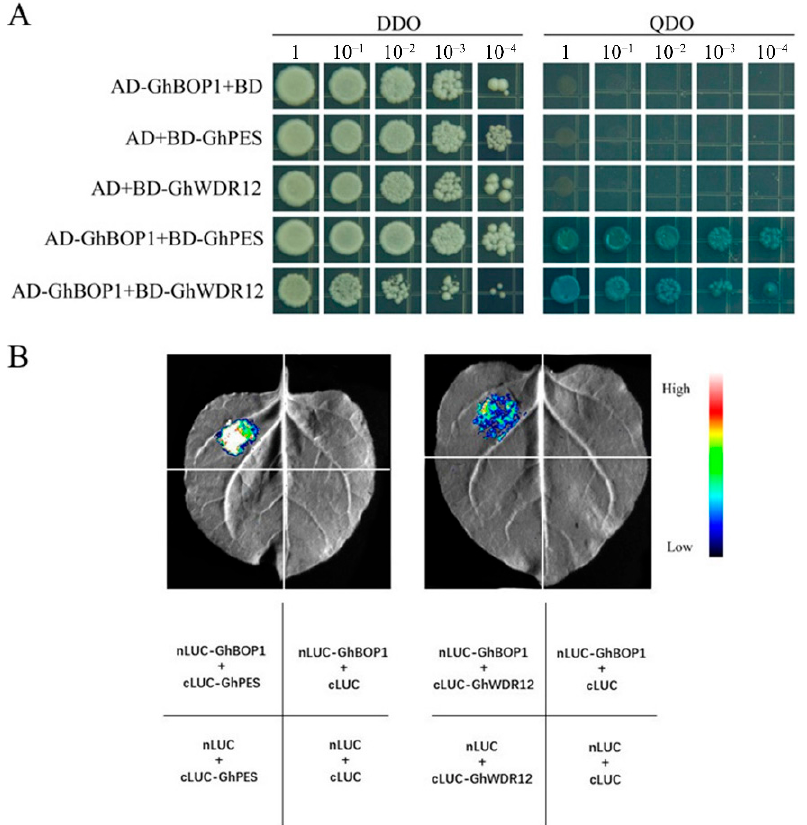
Figure 2. Interaction of GhBOP1 with GhPES and GhWDR12. ( A ) The interaction of GhBOP1 with GhPES and GhWDR12 was verified by yeast two-hybrid method, and blue yeast indicated that they interacted. DDO represents the SD-Trp/Leu medium, and QDO represents the SD-Trp/Leu/His/Ade + X- α -Gal medium. ( B ) Interaction of GhBOP1 with GhPES and GhWDR12 was verified by conducting the luciferase complementation experiment, and their interaction was indicated by fluorescence.